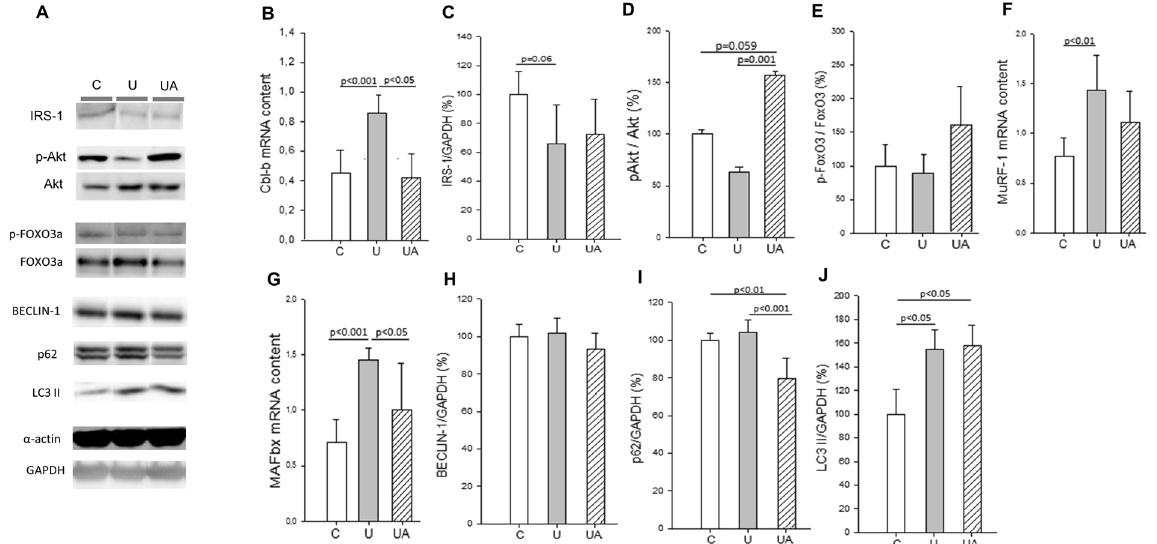
Figure 3. Allopurinol up-regulates the IGF-1/Akt pathway and down-regulates muscle atrophy-related E3 ubiquitin ligases in skeletal muscle. ( A ) Representative western blotting of soleus proteins (full-length blots are included in supplementary information. See Supplementary Figure 3). ( B ) Shows mRNA levels of Cbl-b in soleus muscle. ( C to E ) Show the densitometric analysis quantified using relative expression in arbitrary units of IRS-1 ( C ), p-Akt ( D ), p-FoxO3 ( E ). ( F and G ) Show the soleus muscle mRNA levels of MuRF-1 ( F ) and MAFbx ( G ). ( H to J ) Show the densitometric analysis quantified using relative expression in arbitrary units of Beclin-1 ( H ), p62 ( I ), and LC3-II ( J ). Actin and GAPDH were used as a loading control in the western blots, as indicated. Data are shown as mean ± SD, C (n = 4–6), U (n = 4–5), and UA (n =